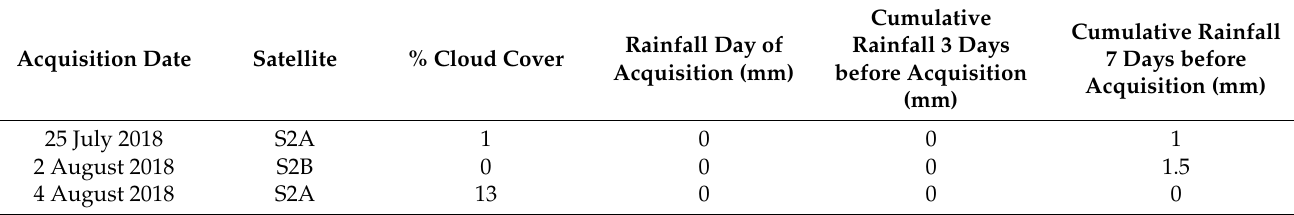
Table 1. Sentinel-2 satellite imagery